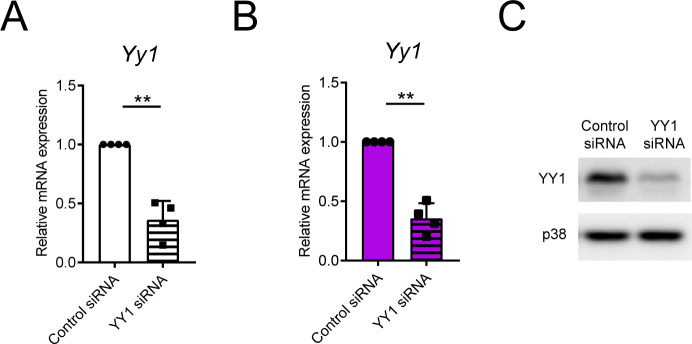
YY1 expression is efficiently knocked down by RNA interference.(A) qPCR analysis of Yy1 in WT BMDMs transfected with control or YY1 siRNAs, normalized to mRNA expression in control siRNA transfected cells. (B and C) qPCR analysis of Yy1 (B) and immunoblotting analysis of YY1 and p38 (loading control, C) in TKO BMDMs transfected with control or YY1 siRNAs, qPCR results were normalized to mRNA expression in control siRNA transfected cells. **p<0.01 (paired Student’s t-test). Data are pooled from (A) or are representative of (B) four independent experiments (mean + s.d.).